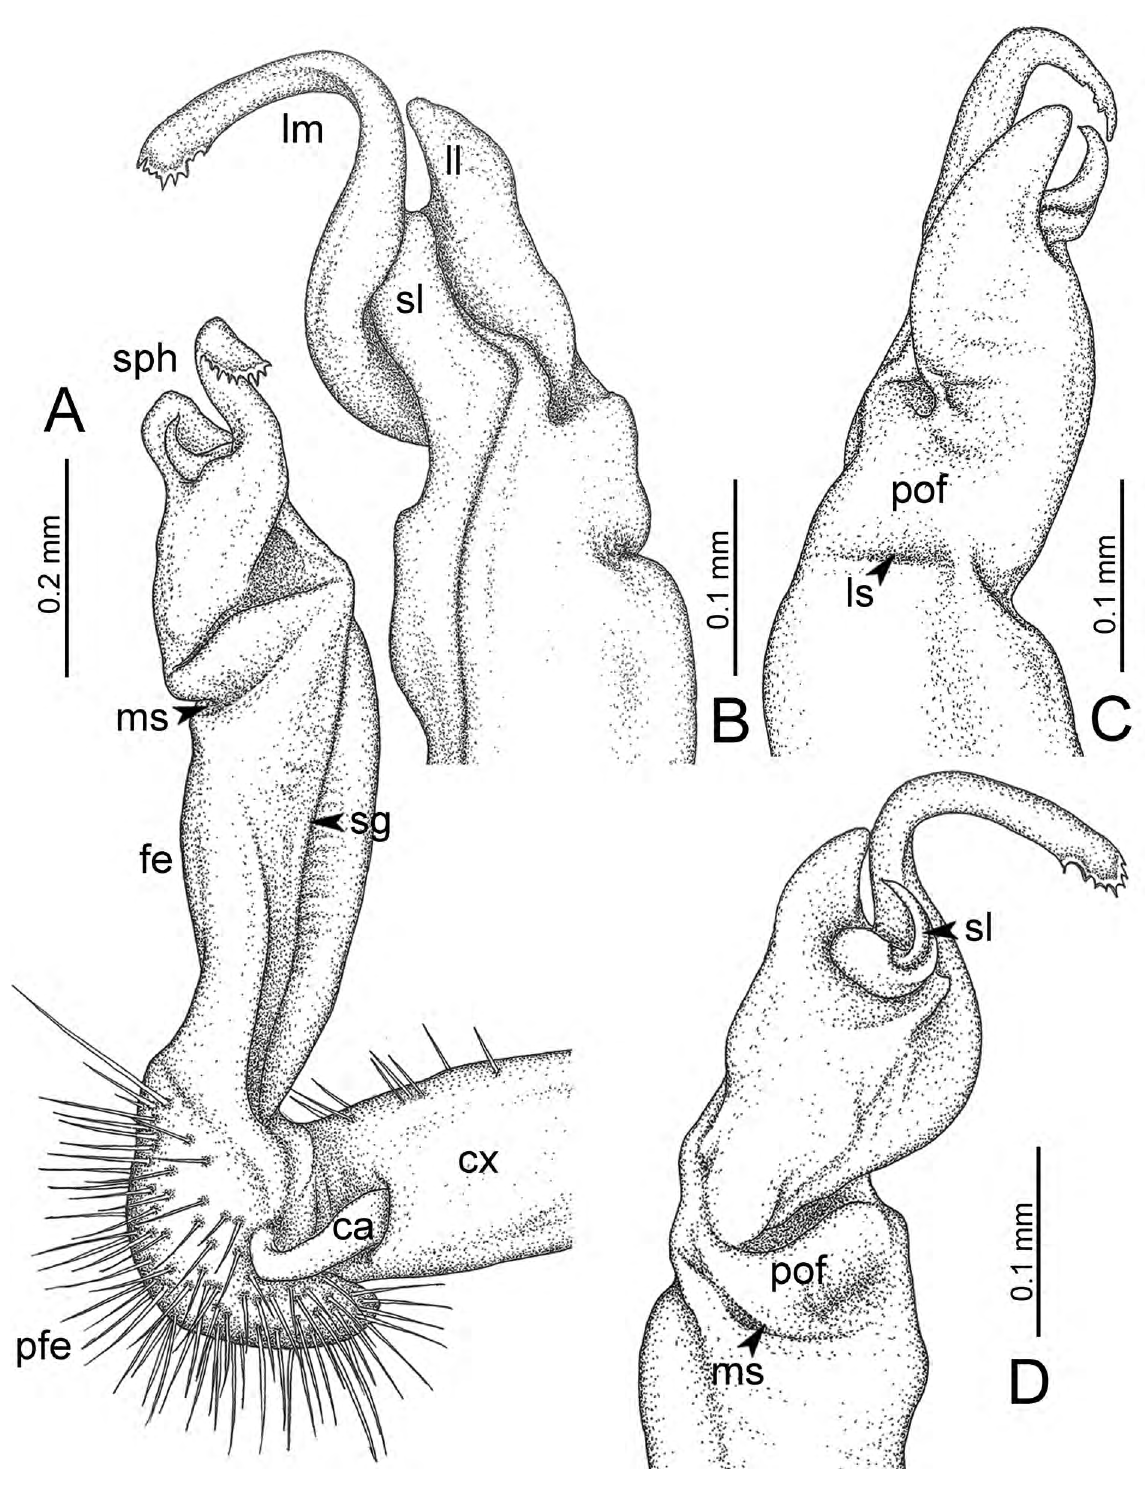
Fig. 15. Nagaxytes erecta Srisonchai, Enghoff & Panha gen. et sp. nov. (paratype, CUMZ-pxDGT00002), right gonopod. A . Mesal view. B . Dorsal view. C . Lateral view. D . Ventral